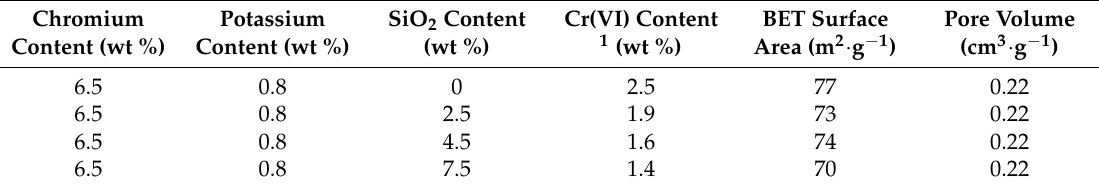
Table 5. Composition, Cr(VI) content, specific surface area and pore volume of the initial and SiO 2 ‐ modified catalysts.